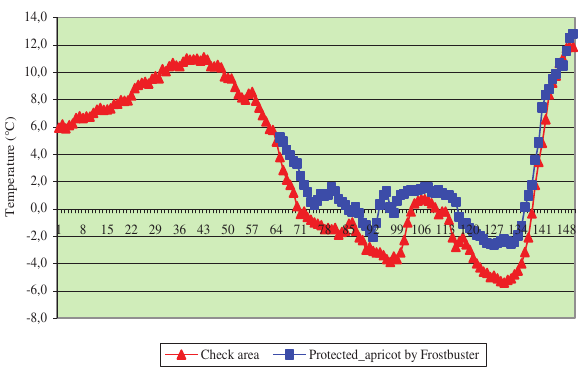
Figure 4 – The temperature measured in the intense apricot planting being protected by the paraffi n candles (blue) and parallelly, of the check area